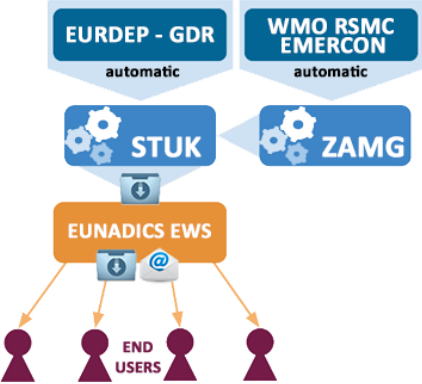
Figure 17. Approach taken for the interface between radiological data and the final notification to end users.